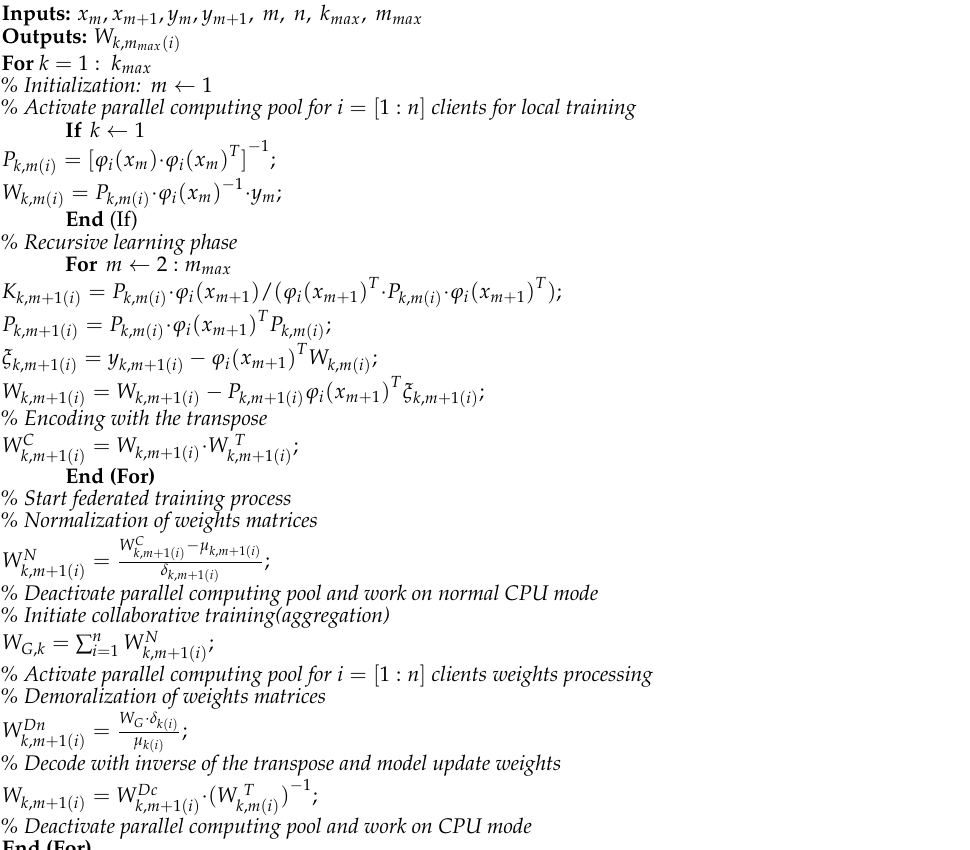
Algorithm 2 . FTL-RLS